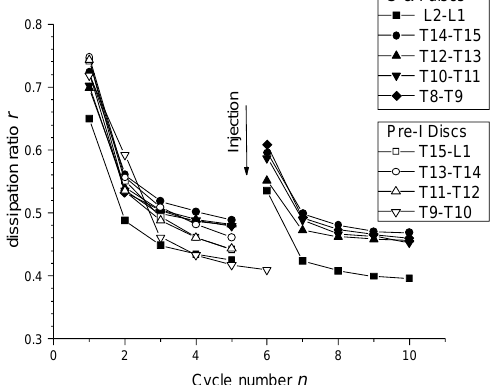
Figure 12. Mechanical dissipation ratio of the compression loading/unloading cycle analyses of healthy and injected discs (S and I); and discs pre-injected (Pre-I) before mechanical testing (see Section 2. Materials and Methods). Analyses were performed in different thoracic-lumbar (T-L) discs of a pig model. Injection of CNF/CHI formulation induced rehydration of the disc and thereby a partial recovery of the mechanical dissipation ratio.